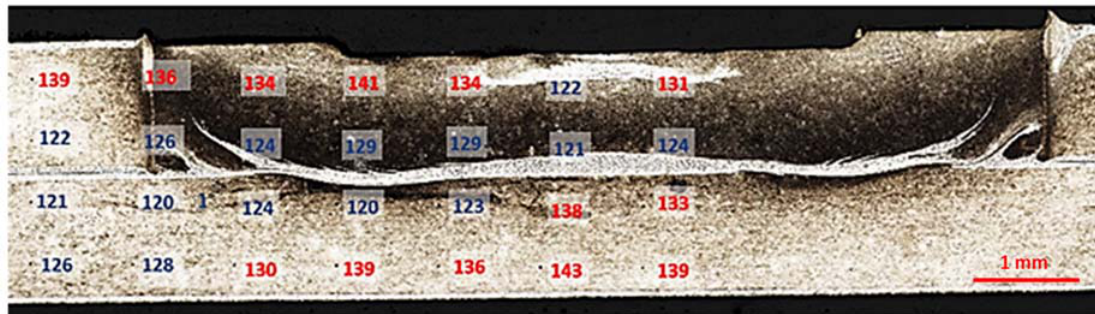
Figure 10. Microhardness of RFSSW .